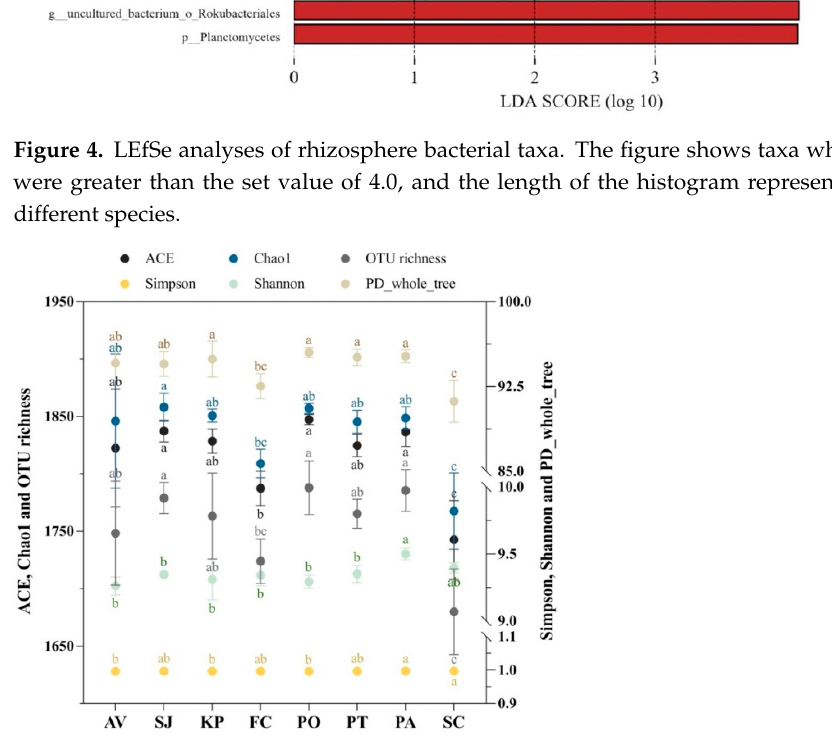
Figure 6. Nonmetric multidimensional scaling (NMDS) of rhizosphere bacterial community in dif ‐ ferent stands. (AV, A. vulgaris ; SJ, S. japonica ; KP, K. paniculata ; FC, F. chinensis ; PO, P. orientalis ; PT, P. tabuliformis ; PA, P. asperata ; SC, S. chinensis .)